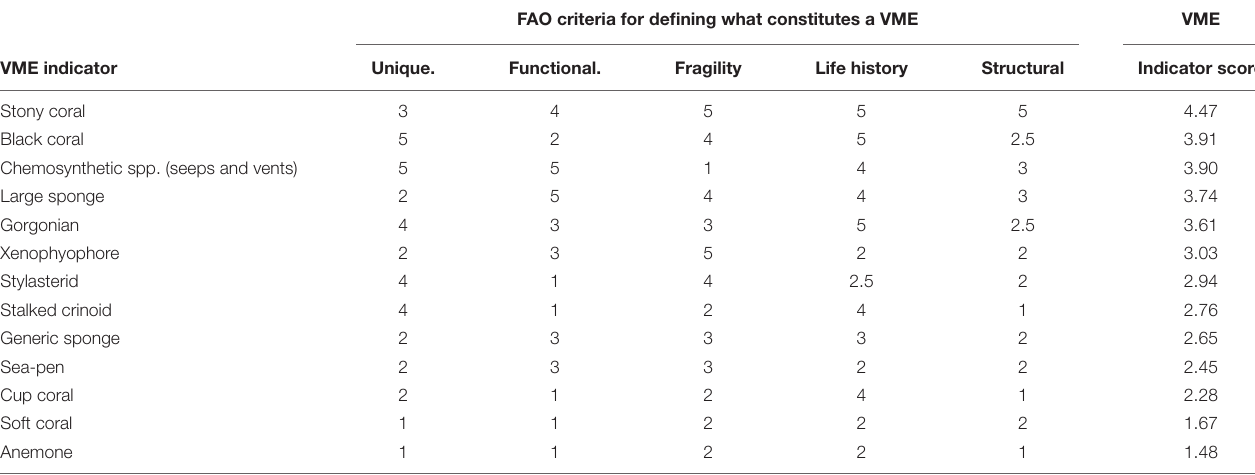
TABLE 1 | Scores for VME indicators occurring in deep-water in the ICES/NAFO area based on the degree to which each VME indicator fit each of the five FAO criteria (FAO, 2009). FAO criteria for defining what constitutes a VME VME VME indicator Unique.